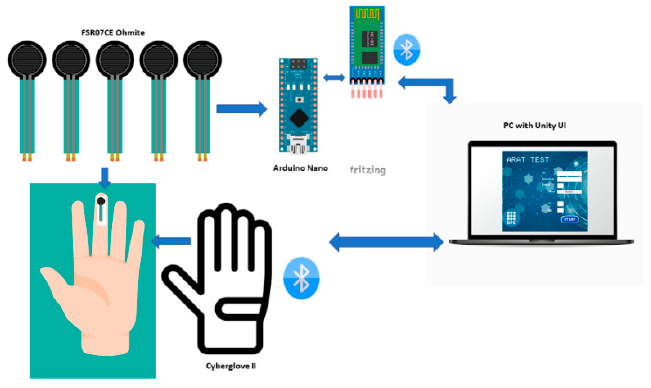
Figure 1. The hand motion system diagram for measuring flexion angles and finger